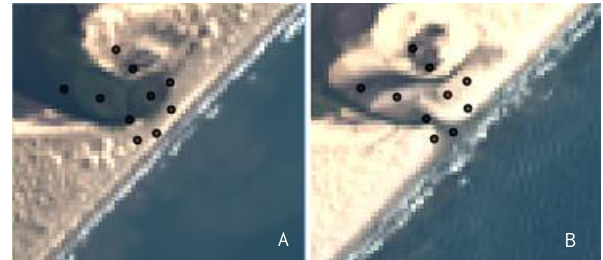
Figure 3. The points where the clustering maps were analyzed, over the color composite for the 08/03/2013, closed (A), and 12/15/2017, open channel (B) situations.